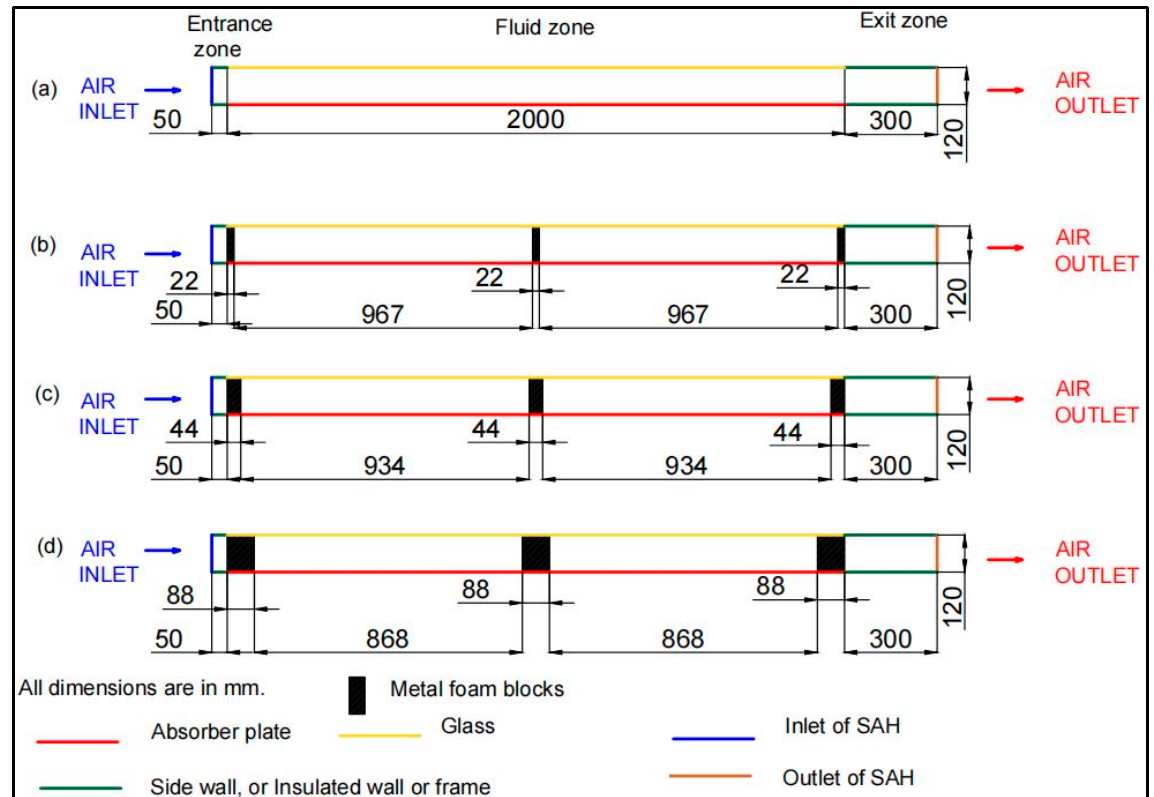
Figure 2. Schematic of SAH: ( a ) empty channel SAH, ( b ) 22 mm filled metal foam SAH, ( c ) 44 mm filled metal foam SAH ( d ) 88 mm filled metal foam SAH. Table 3. Boundary conditions used during simulation in SAH [2,13,14,17,37].